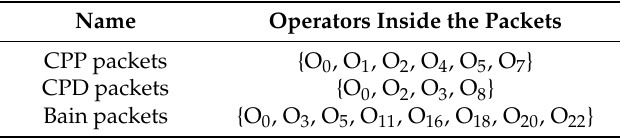
Table 2. Operators’ details in various packets [9]; CPP: close-packed plane; CPD: close-packed